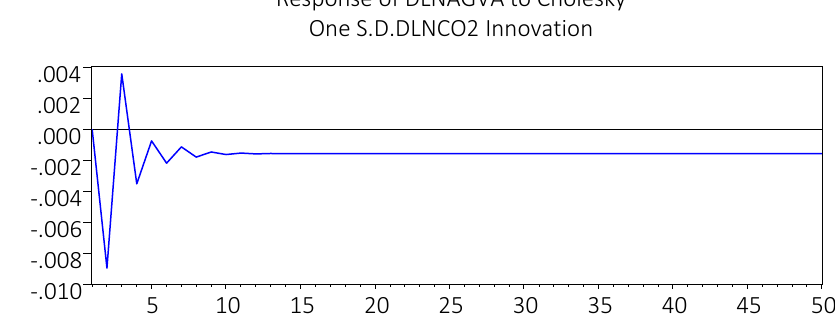
Figure 3a. CO emissions policy response on agricultural development by 2063 (African Union agenda) 2